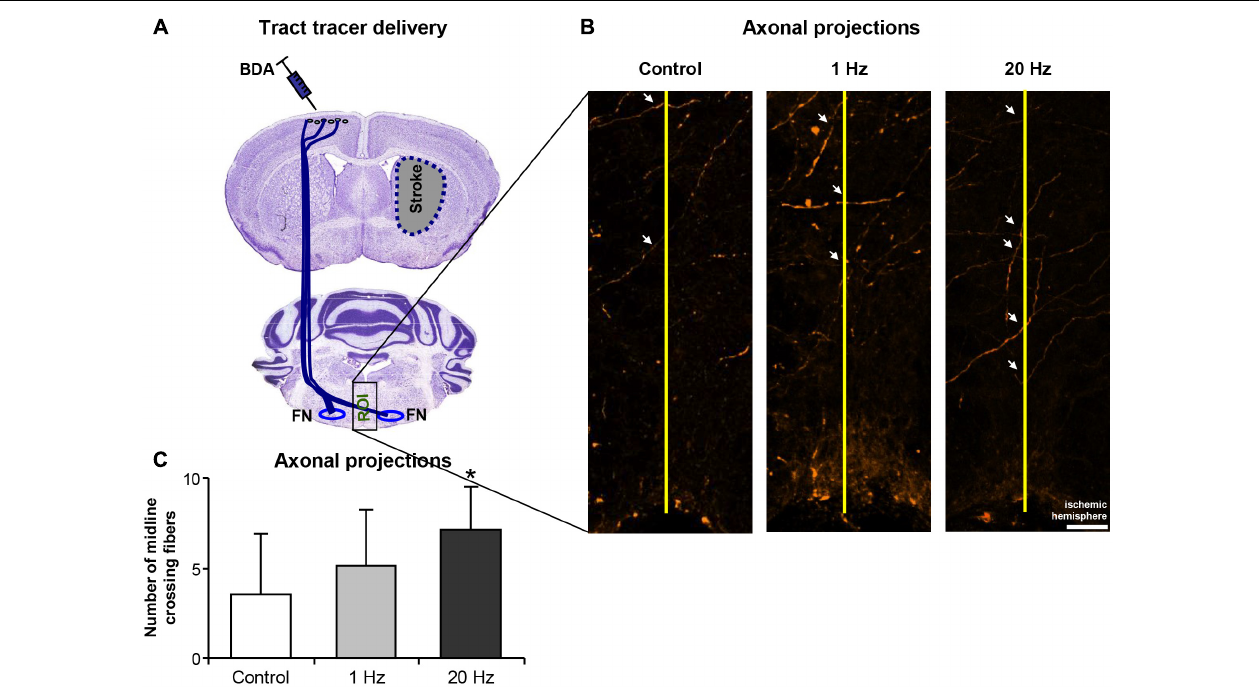
FIGURE 8 | 20 Hz rTMS stimulates plasticity following cerebral ischemia. Midline crossing axon fibers in facial nuclei was traced by BDA administration after cerebral ischemia (for placement of tracer injections see A ). Axonal projections were evaluated by drawing a virtual straight line (yellow line, B ) at the midline to separate the two hemispheres and to count the number of axons crossing the virtual line (C) . Data were evaluated by one-way ANOVA followed by LSD tests. Data are presented as mean ± SD values. ∗ p < 0.05 compared with control group. Arrows show axonal projections. Scale bar is 100 µ